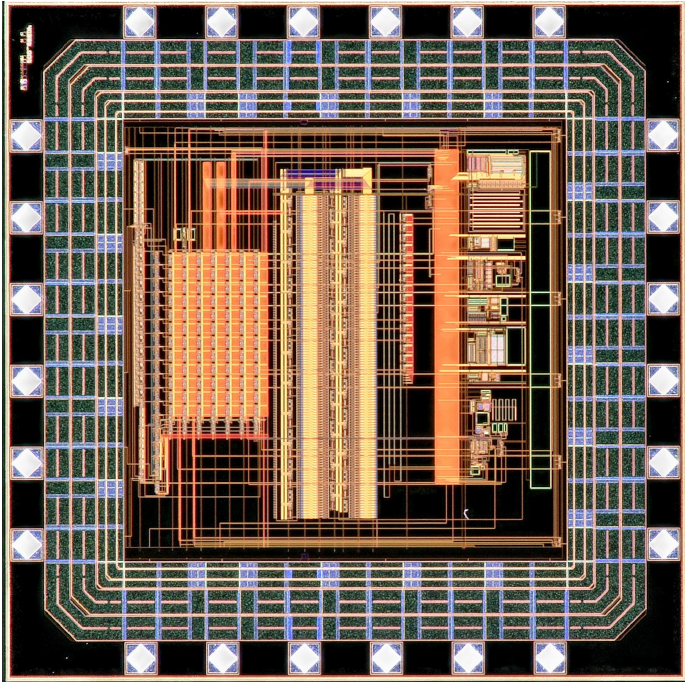
Figure 8. ANTIGONE ASIC microscopic photograph.